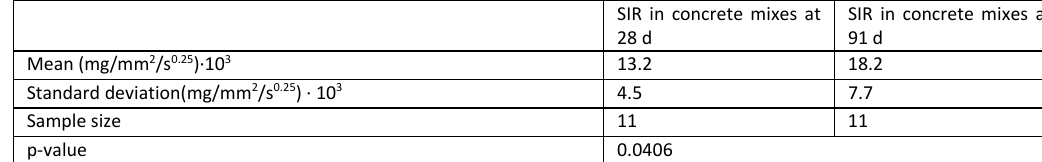
Table 3. Results from a t ‐ test considering independent